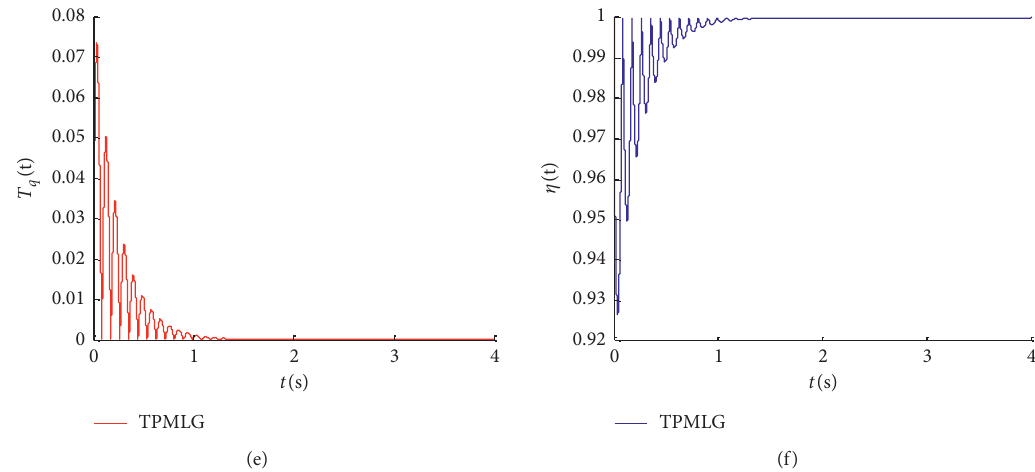
Figure 11: Transmissibility and vibration isolation rate time-history curves of combined devices. (a) Transmissibility curve of spring- cylinder isolation device. (b) Vibration isolation rate curve of spring-cylinder isolation device. (c) Transmissibility curve of spring-rubber isolation device. (d) Vibration isolation rate curve of spring-rubber isolation device. (e) Transmissibility curve of spring-aluminum foam isolation device. (f) Vibration isolation rate curve of spring-aluminum foam isolation